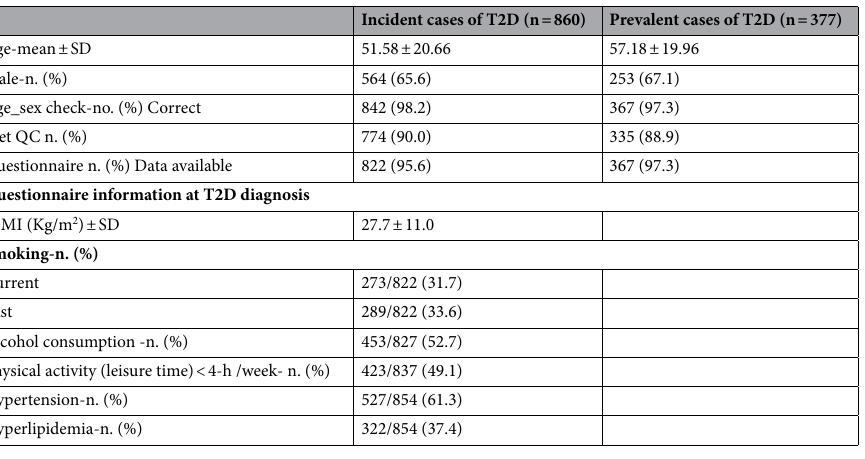
Table 1. Baseline characteristics of incident and prevalent patients with T2D with genetic information available in UCP. Data were shown as mean ± Standard deviation (SD).Categorical variables are shown as frequencies (percentage). *BMI: body mass index (the weight in kilogram divided by the square of the height in